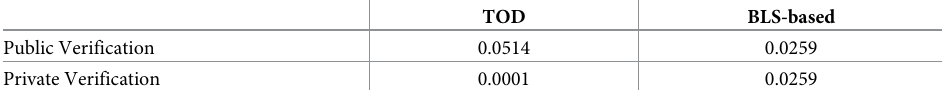
Table 11. TOD method vs. BLS based tagging method: The required time (in seconds) of private and public tag verification.